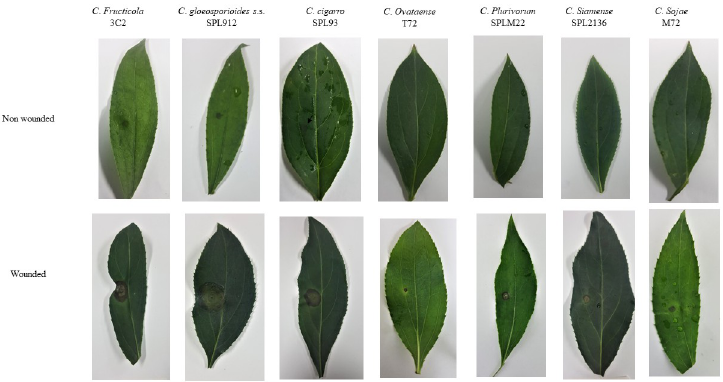
Fig 18. The symptoms of OLA leaves induced by Colletotrichum spp. with unwounded and wounded inoculation. The lesion on leaves were photographed seven days post inoculation. The left side of each leaflet was inoculated with 10 μ l spore suspension (10 6 spores/ml) and the right side with water (control).